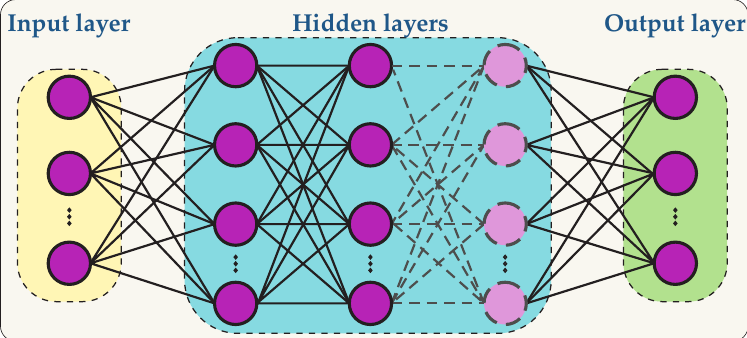
Figure 1. Deep Forward Neural Network